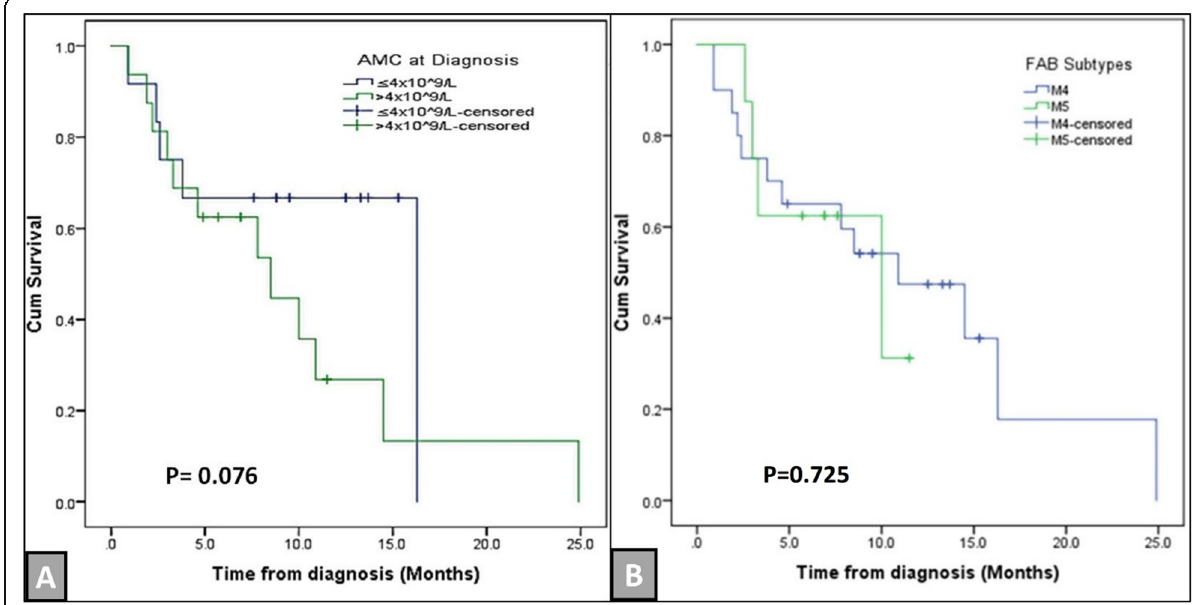
Fig. 5 The 3-year overall survival analysis in different subgroups. a The 3-year overall survival as regard the initial AMC (absolute monocyte count) level. b The 3-year overall survival as regard the